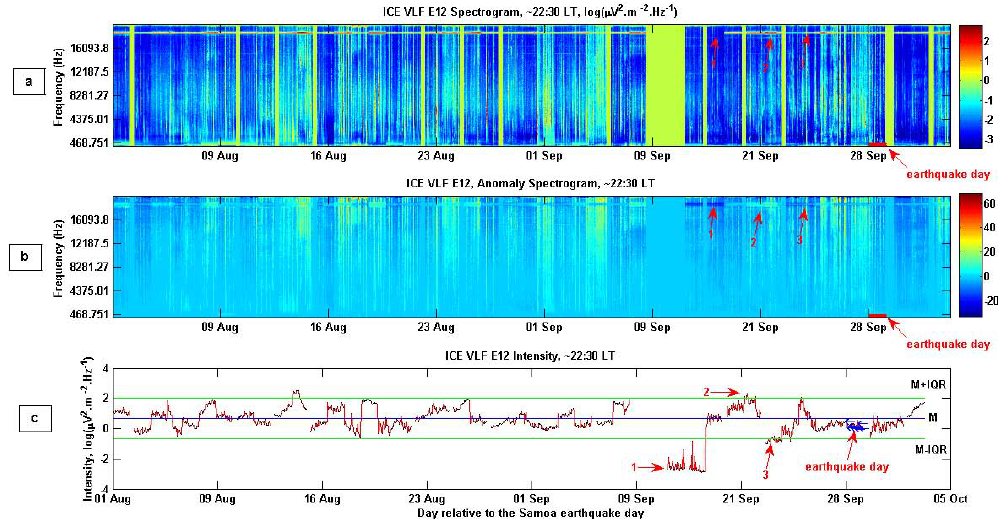
Fig. 2. Results of the DEMETER data analysis concerning the Samoa earthquake (29 September 2009) from 1 August to 5 October 2009 at ∼ 22:30LT. Due to the operation of satellite in safe mode a time gap is observed from 7 to 15 September 2009. The earthquake day is represented by a red tick below the X-axis. (a) ICE VLF spectrogram of the E12 electric component. The intensity of the spectrogram is color-coded according to the scale on the right. (b) Detected anomaly in the ICE VLF spectrogram of the E12 electric component. The anomaly is color-coded according to the scale on the right. (c) Intensity of ICE VLF spectrogram of the E12 electric component around the virtual NPM transmitter frequency (see text for explanation). For this panel the green horizontal lines indicate the higher and lower bounds ( M ± IQR). The blue horizontal line indicates the median value ( M ). In all panels, the X-axis represents days relative to the occurrence of the Samoa earthquake.